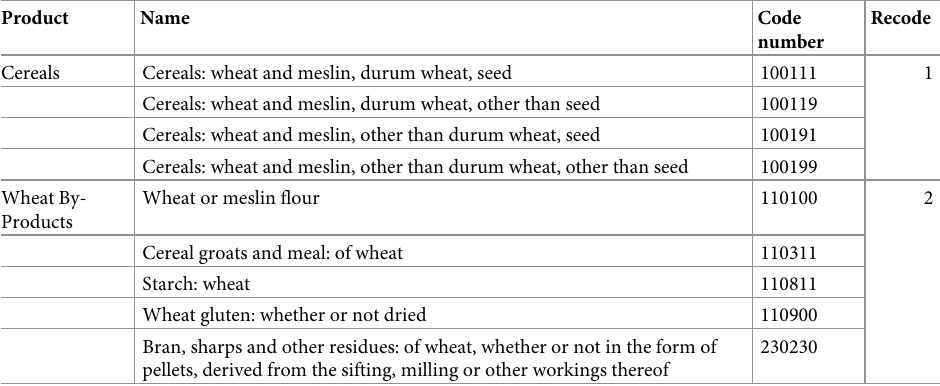
Table 1. Original wheat product codes and